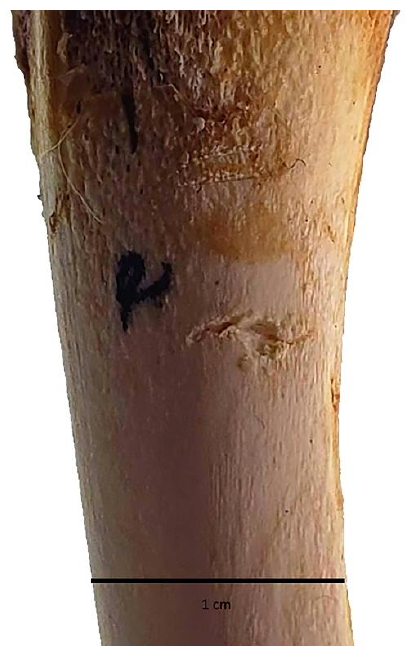
Figure 11. “Peck mark” created by the chert chipped stone axe on a deer radius (cBI 106).